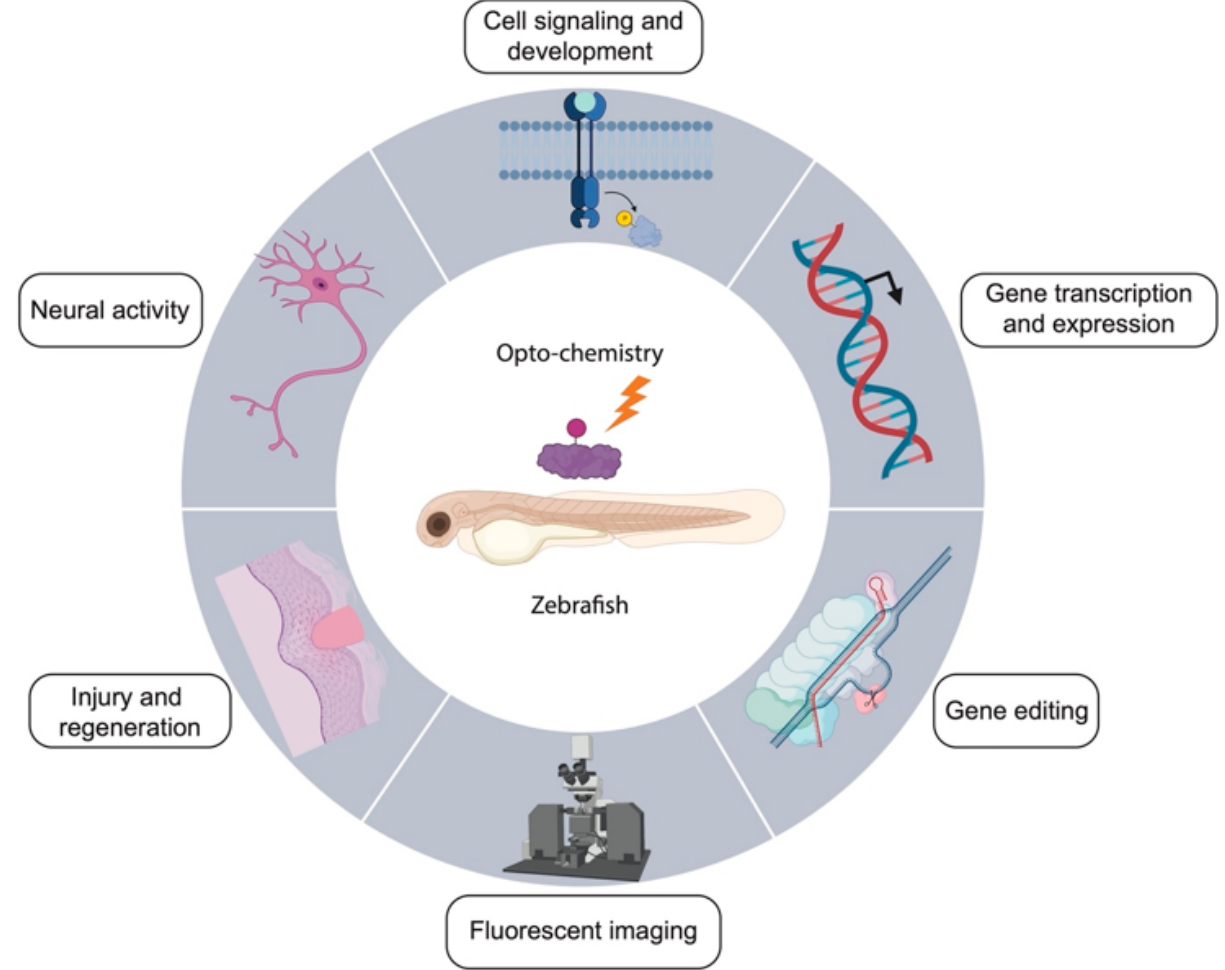
Figure 3. Applications of opto-chemical tools in zebrafish. The representative applications depicted are only those covered in this review. This figure is created with BioRender.com (accessed on 9 July 2022).